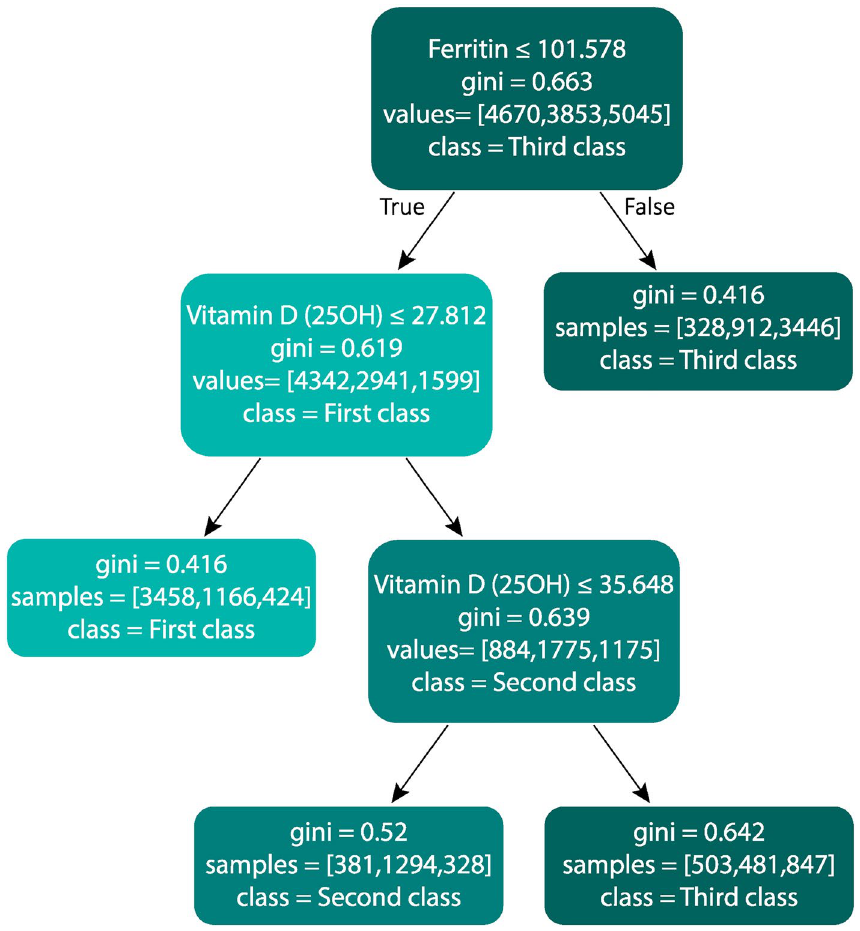
Figure 8. First levels of the random forest decision trees trained to classify the blood creatinine level in three Based on this, and considering that a random forest model has been developed to classify creatinine level, the selected variables at the decision nodes of the random forest must be examined. Because these variables are the blood test parameters with the most effect on the blood creatinine level. Figure 8 shows the variables selected at the first levels of random forest trees created to classify the creatinine level. Each node in the tree contains information about the selected variable for splitting, the Gini impurity index, the number of samples belonging to each class, and the dominant class of samples in the node. The number of samples of each class are specified in square brackets and represent the number of samples in the first, second, and third classes, respectively. Each node of the tree corresponds to a subset of the samples which satisfy the constraints for all nodes above this node (i.e., having greater (less) value than the cutting point for the splitting variable of decision nodes). The Gini impurity index for each node measures the impurity of the samples in the corresponding subset, and less value for this index indicates more consistency of the samples’ classes. This index is used to select a splitting variable and cutting point that will result in subsets with more purity. The selected variables in the first three levels represented in Fig. 8 are the same in most random forest trees, but the cut points selected for these variables differ for each tree. These slight differences in the cutting points of random forest trees are due to the different samples used in the training of each tree. As can be seen in Fig. 8, the ferritin and vitamin D levels have been selected as the most influential variables on the creatinine level in the first levels of the tree. Vitamin D levels were selected two times to divide the sam- ples into subsets with higher purity, and each time the class assigned to the right branch of the decision node had higher creatinine levels than the class of the left branch. The first decision node related to vitamin D at the second level of the tree selects the cut point of 27.812 for this variable. Hence, samples for which vitamin D levels were lower than 27.812 are assigned to the first creatinine class and samples with higher levels for vitamin D are allocated to the second creatinine class. Similarly, in the second decision node associated with this variable at the third level of the tree, samples containing values lower than the cut-off point are assigned to the second creati- nine class and samples containing values greater than the cut-off point are assigned to the third creatinine class. These observations indicate a direct relationship between the vitamin D and blood creatinine levels. A similar